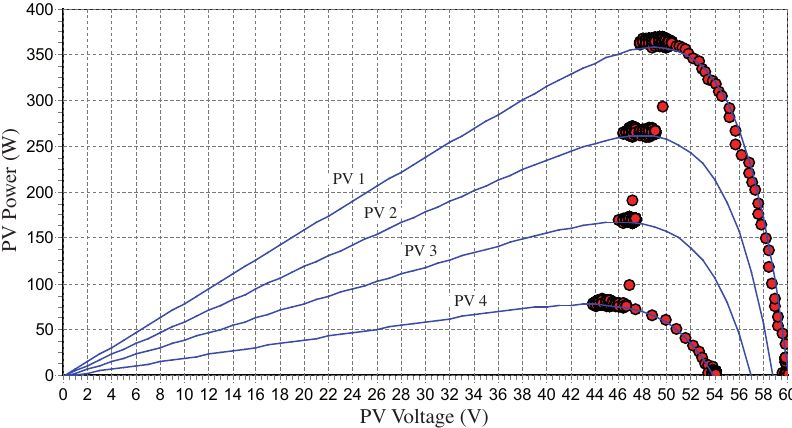
Figure 14. Operating point shift during irradiance step changes from PV1 to PV4 (samp. time = 2